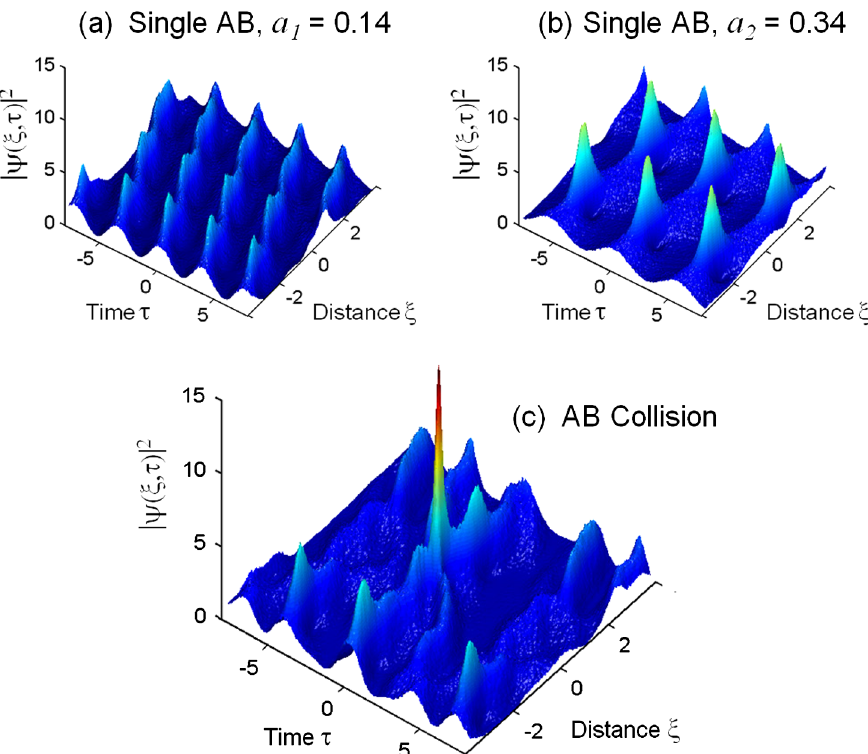
FIG. 4. NLSE simulations: Single breather evolution with nonideal excitation (a) for a 1 ¼ 0 : 14 and (b) for a 2 ¼ 0 : 34 . (c) Collision of the two ABs when excited simultaneously by using the superposition of initial conditions of (a) and (b). Note that initial conditions are arbitrarily injected at (cid:1) 0 ¼ (cid:1) 4 to get the collision at the origin for a better comparison with theory (see Fig.